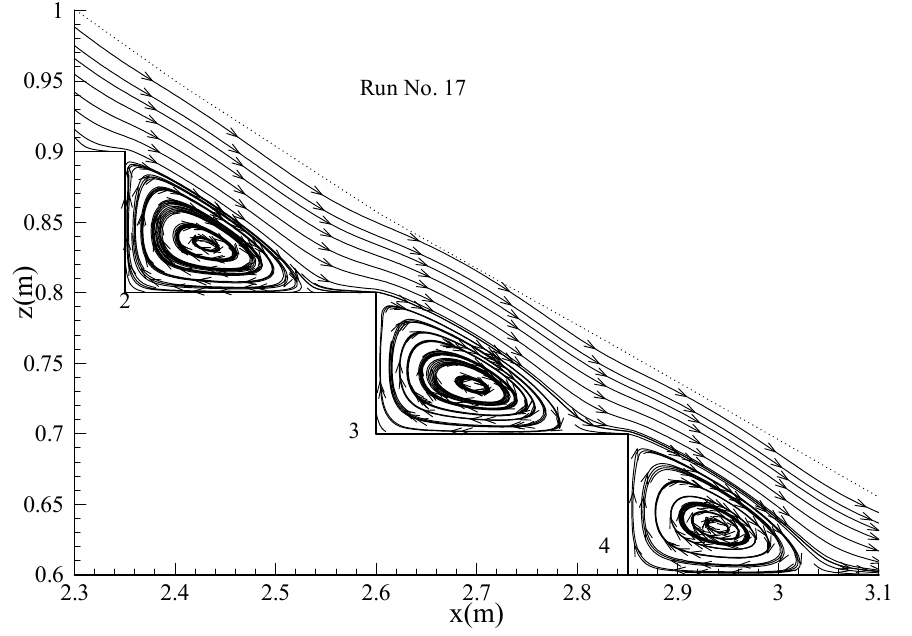
Figure 15. Part of numerical flow streamlines from second to fourth steps at Run No.